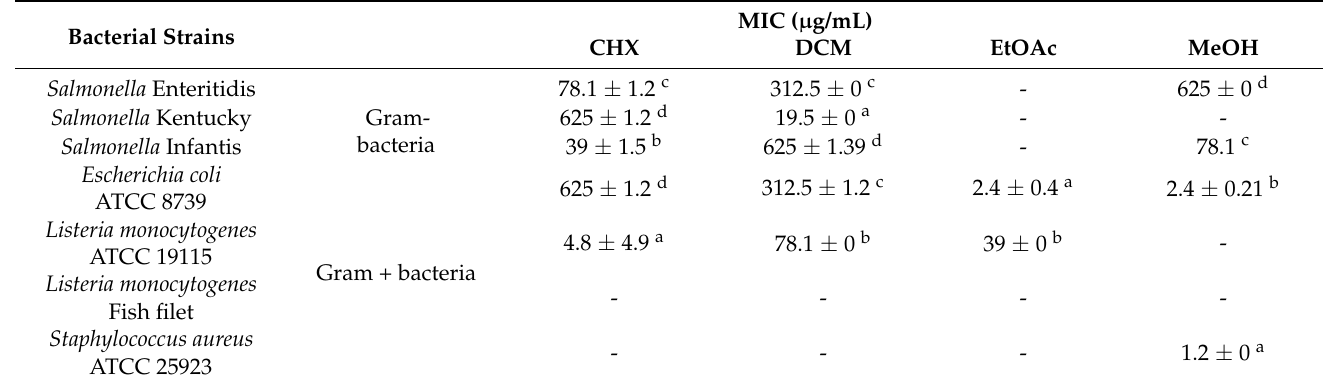
Table 4. Minimum inhibitory concentration (MIC) values obtained with the S. fruticosa extracts tested against seven foodborne Gram-positive and Gram-negative pathogenic